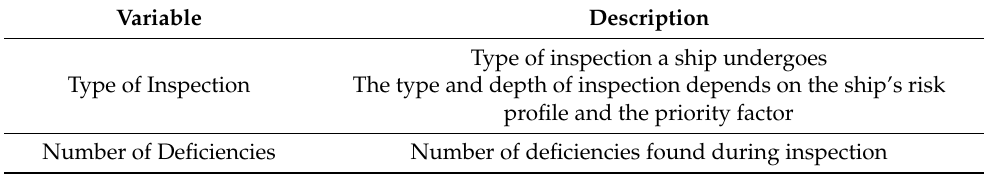
Table 2. Inspection